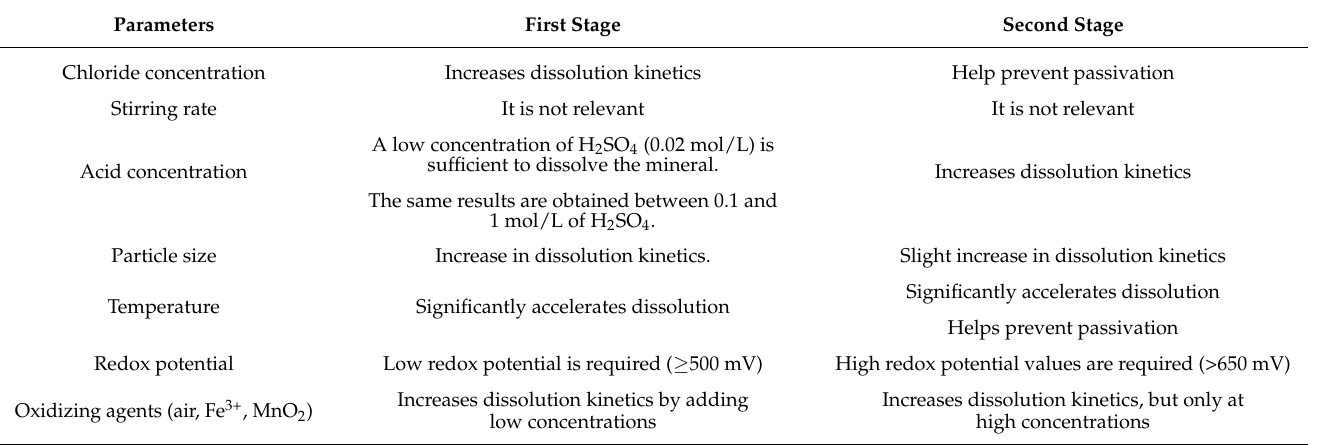
Table 5. Impact of the different operational parameters on the dissolution of Cu 2